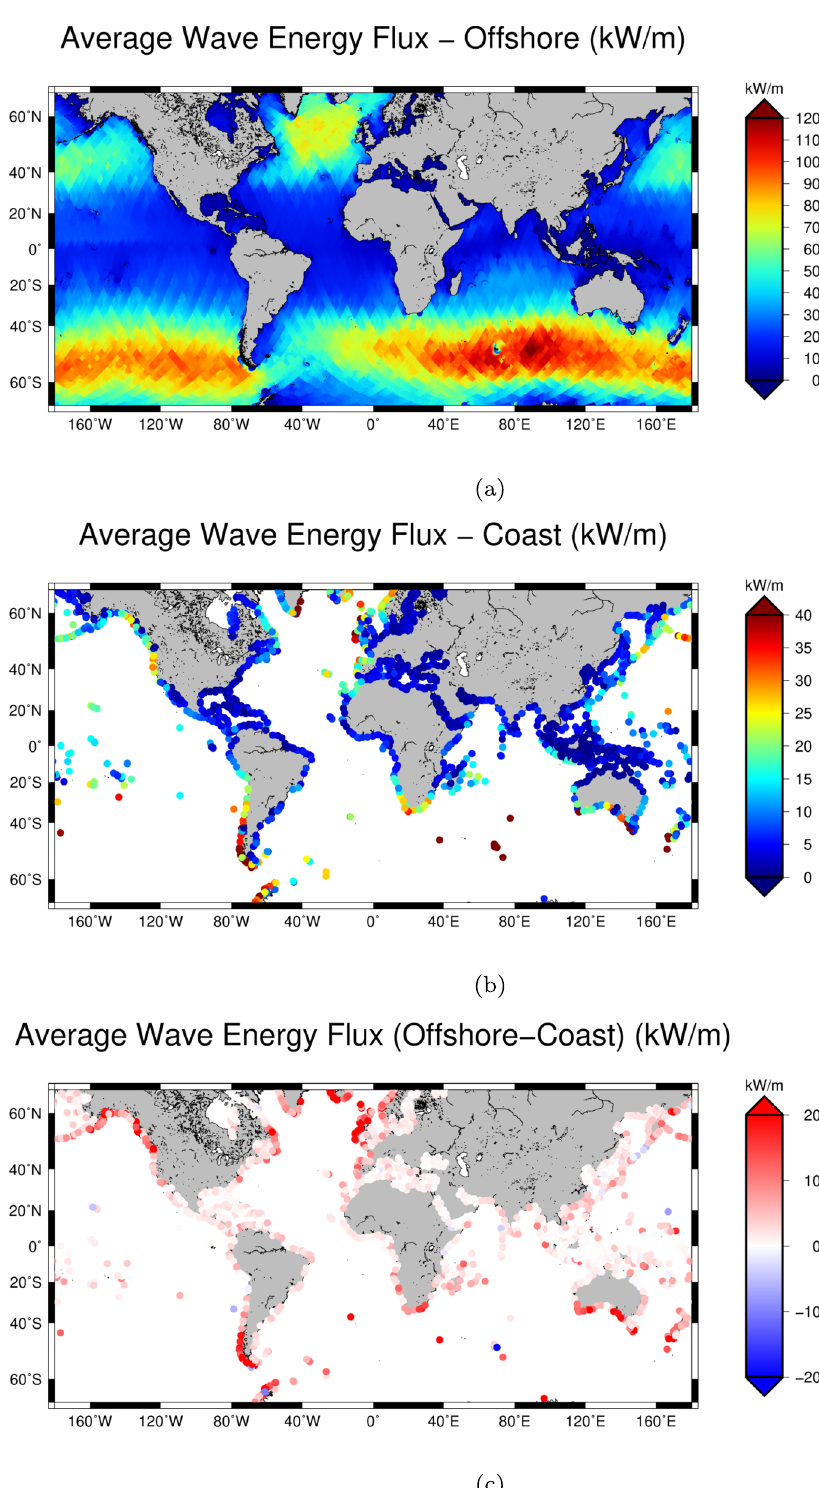
Fig. 4 Average wave energy fl ux. Average wave energy fl ux from along-track satellite altimetry over the global ocean ( a ) and along the coastline ( b ). ( c ) shows the difference between the offshore and the coastal